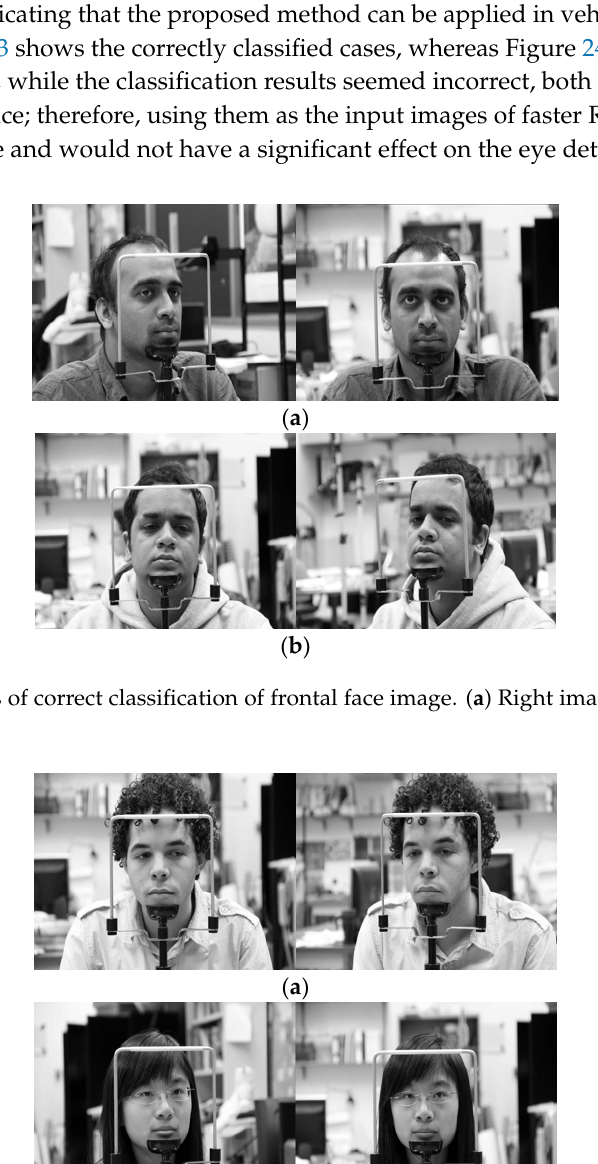
Table 10. Classification accuracy of frontal face image using shallow CNN (unit: %).